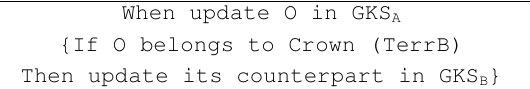
Figure 11. A town, its own crown and the crowns of its